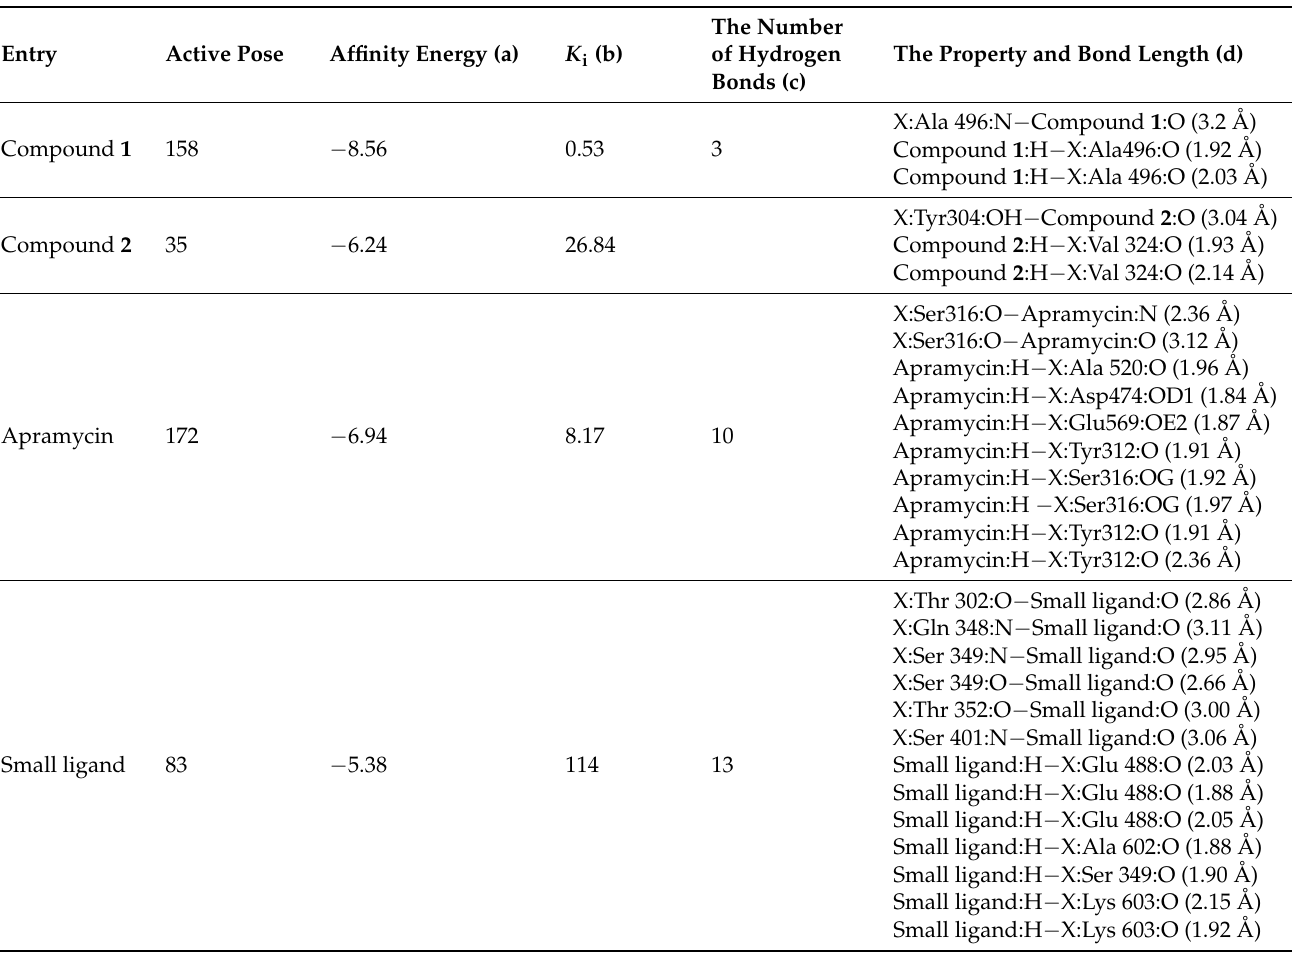
Table 4. The essential calculation results for the in silico docking model of ligands such as compounds 1 and 2 , apramycin, and small ligand in receptor 2VF5 to the receptor 2VF5 (PDB).